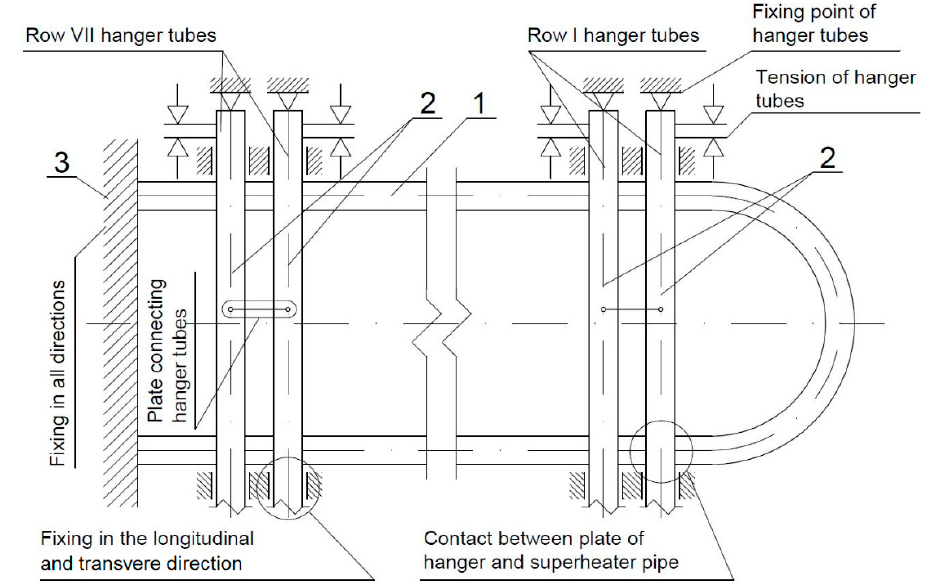
Figure 2. Boundary conditions of superheater SH3 hanger.